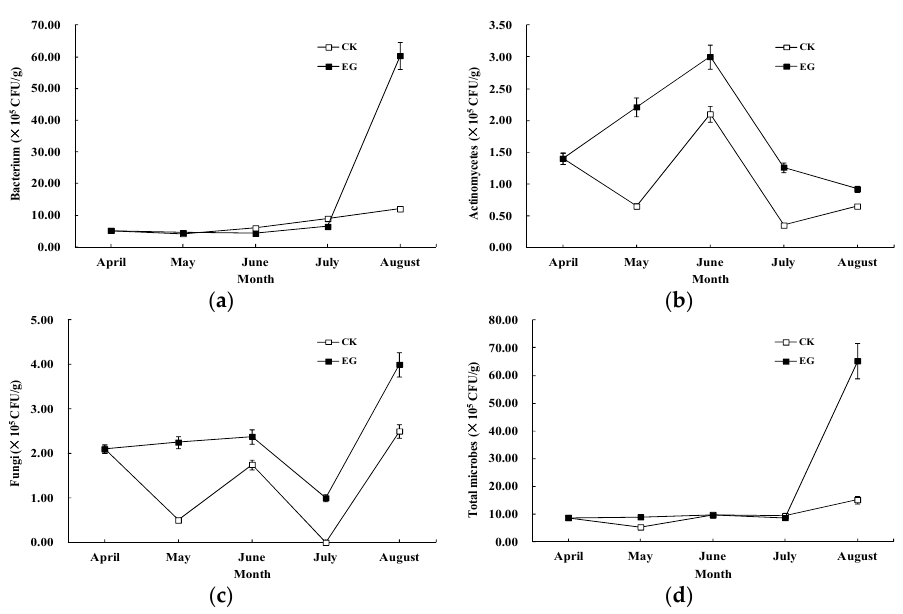
Figure 1. Changes of microbial counts in kiwifruit planting soil: ( a ) bacterium; ( b ) actinomycetes; ( c ) fungi; and ( d ) total microbes.